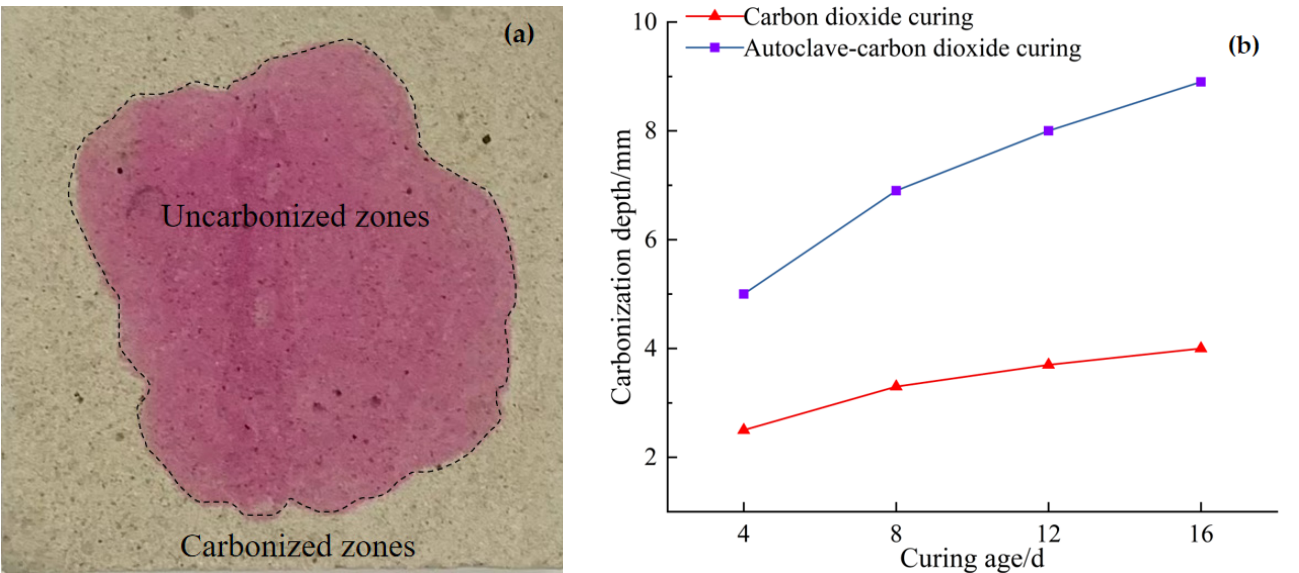
Figure 9. Carbonization depths of gray brick under different curing methods. ( a ) Carbonation diagram of specimen III-A-2; ( b ) carbonation depths of gray brick.